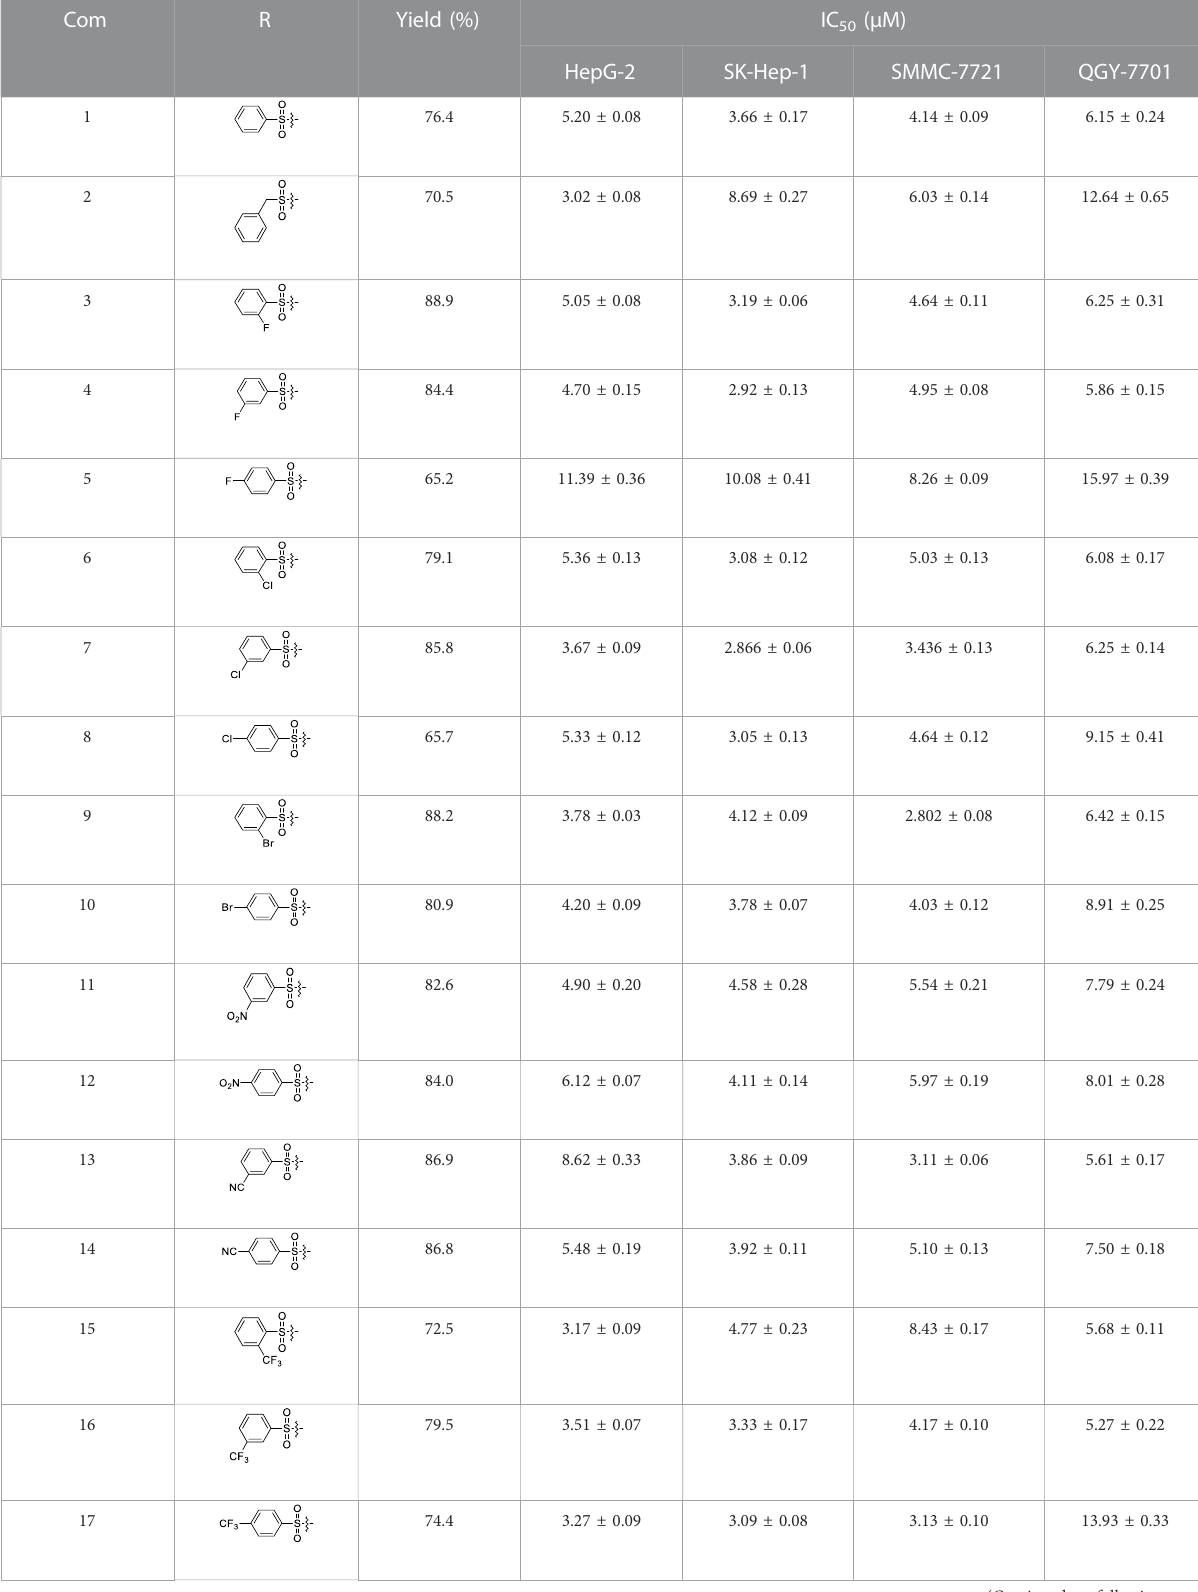
TABLE 1 Cytotoxic activity of the examined compounds against HepG2, Sk-Hep-1, SMMC-7721, QGY-7701 cells.